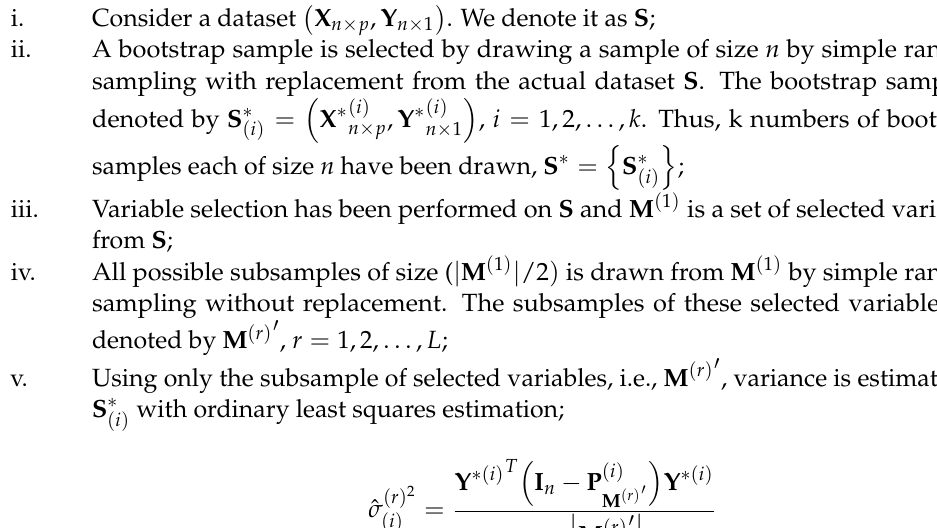
Figure 3. Bootstrap with